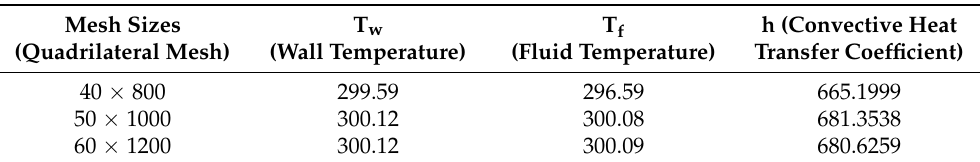
Figure 1. ( a ) Test Section Geometry ( b ) Sectional view of the Mesh Geometry ( c ) Temperature Contour for Re = 800 ( d ) Inner Wall Temperature along the length for various Reynolds numbers. Table 1. Grid Independence Study.